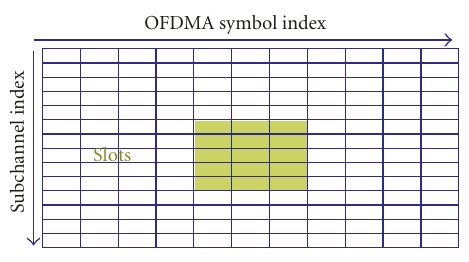
Figure 2: OFDMA based Slot